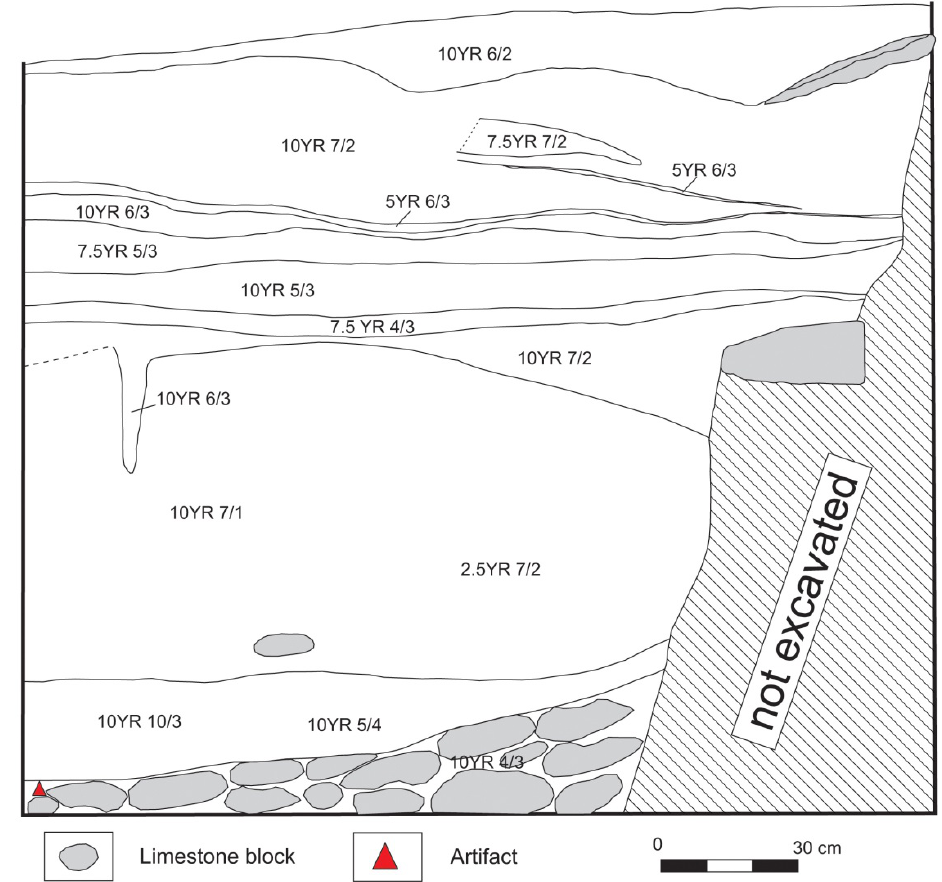
Figure 4. Lapa Grande de Taquaraçu, Unit H8 - north profile image, showing a thick anthropogenic sediment accumulation over the basal layer of limestone pebbles and cobbles where the artifact was recovered. The location of the artifact is indicated by a triangle. Drawing by Astolfo Araujo.